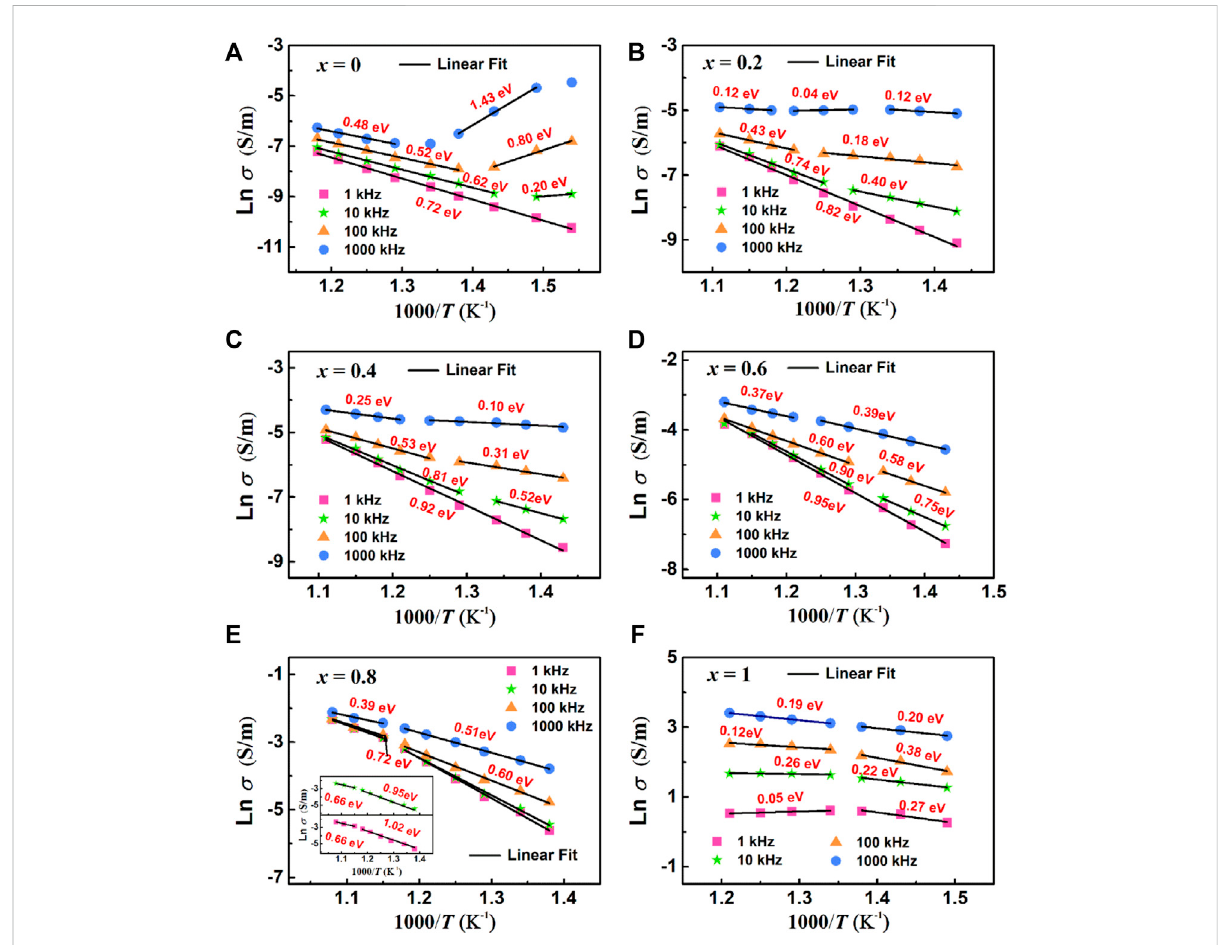
FIGURE 12 Arrheniusplots ofACconductivity atdifferentfrequency: (A) BBT, (B) 0.8BBT-0.2BiT, (C) 0.6BBT-0.4BiT, (D) 0.4BBT-0.6BiT, (E) 0.2BBT-0.8BiT, and (F)